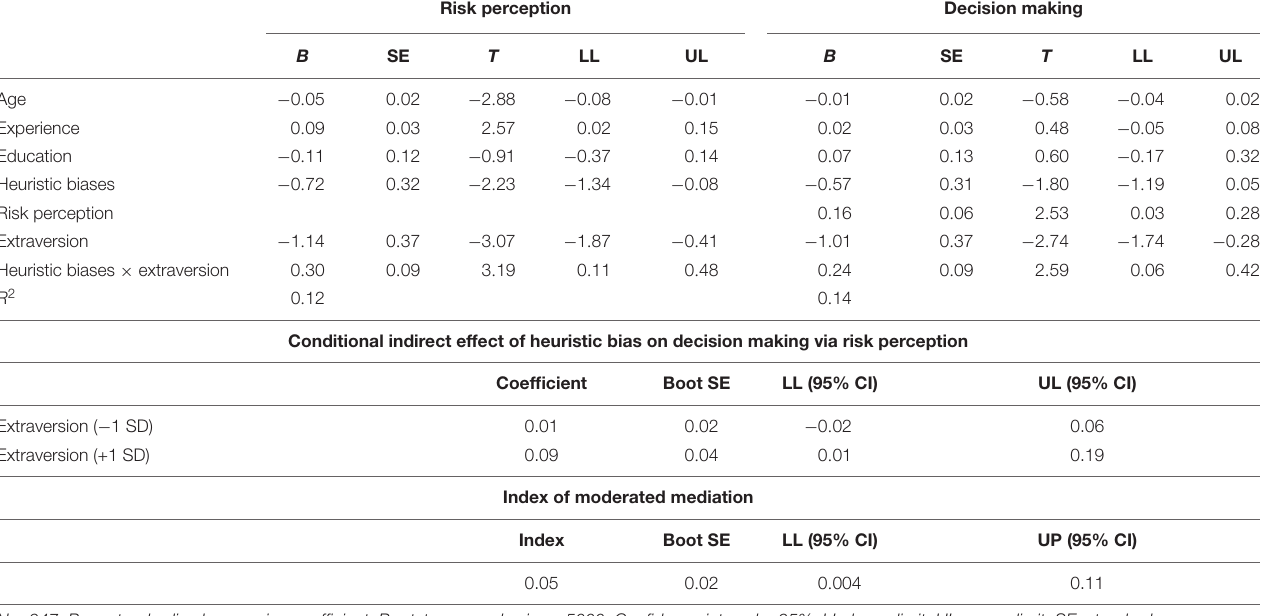
TABLE 4 | Extraversion as a moderator of the relationships of heuristic biases with risk perception and decision-making. Risk